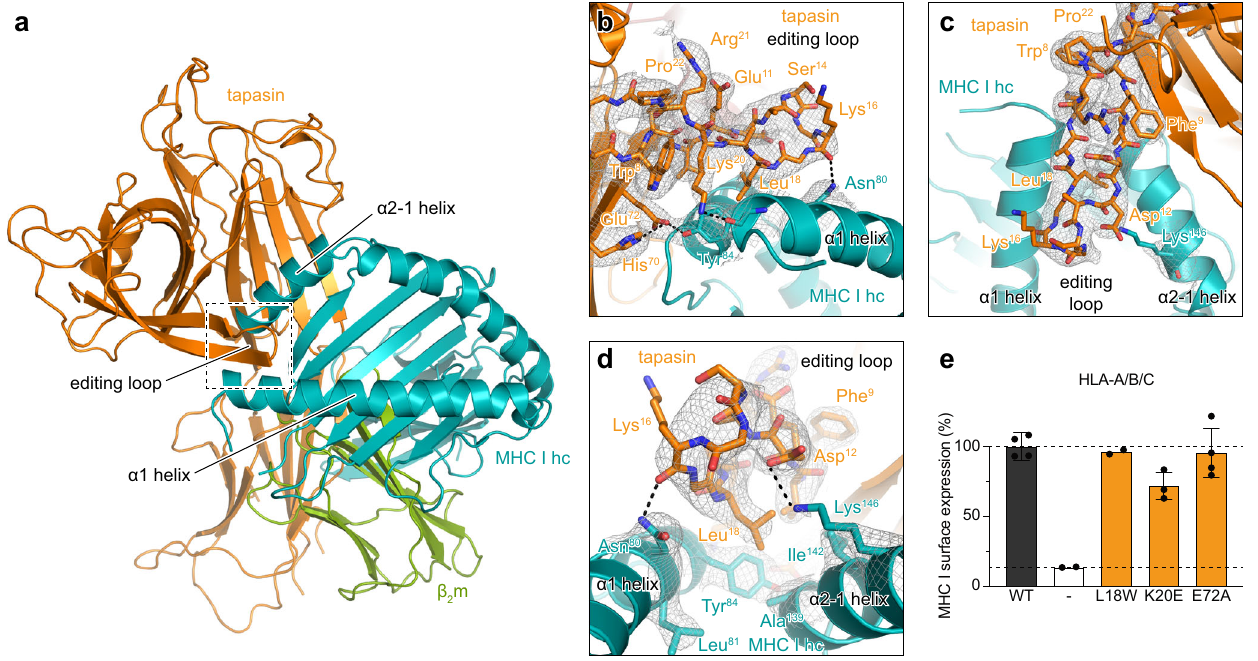
Fig.3|TheeditingloopoftapasincontributestoawidenedF-pocketofMHCI. a Cartoon representation of the chaperone complex as shown in Fig. 1c. Tapasin, MHC I hc and β 2 m are colored in orange, teal and green, respectively. Region magni fi ed in b – d is indicated by a dashed box. ERp57 is not shown for the sake of clarity. b Side view onto the editing loop (stick representation) of tapasin with corresponding electron density map (contour level: 1.5 σ ). Dashed lines represent hydrogen bonds or salt bridges. The same color code as in a is applied. hc heavy chain. c Top view onto the editing loop with corresponding electron density and color code as shown in b . d Close-up view into the F-pocket of MHC I with corre- sponding electron density and color code as displayed in b . e MHC I surface expression of tapasin-de fi cient HAP1 cells (white), expressing wildtype (WT, dark